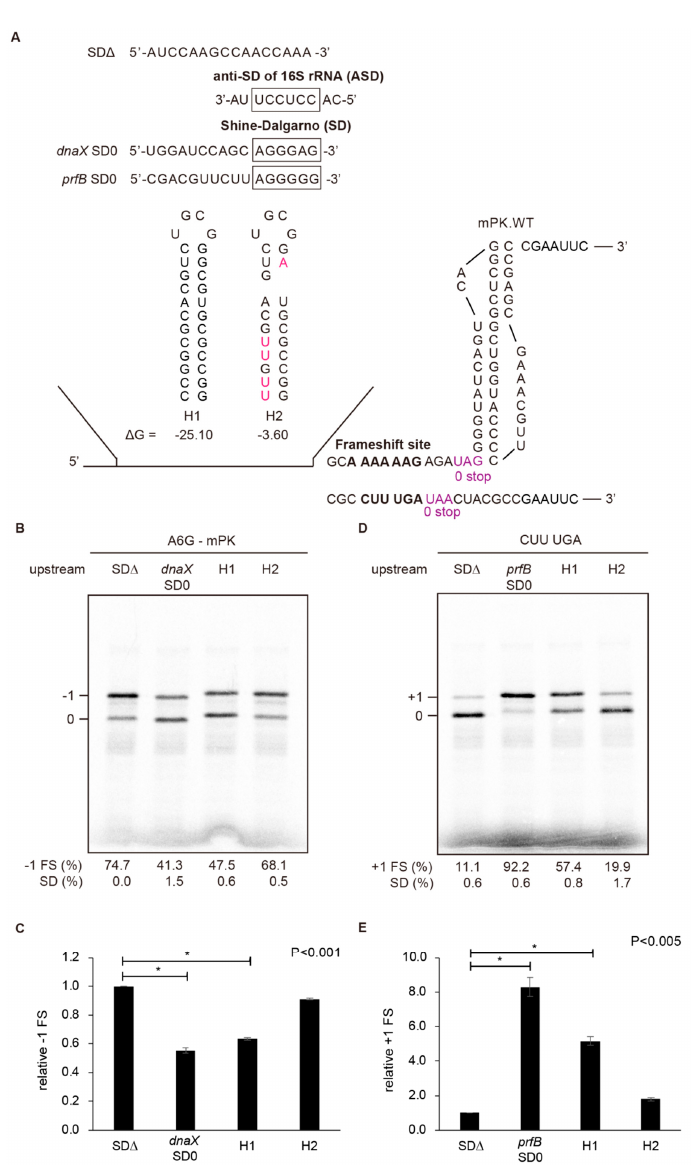
Figure 2. Stimulation of +1 frameshifting as well as attenuation of − 1 frameshifting by internal SD-mediated duplex mimicries in an in vitro 70S translation system. ( A ) Sequences, predicted secondary structures and free energy of distinct upstream hairpins evaluated. Mfold [25] was used for mRNA secondary structure and free energy prediction. Effects of upstream duplex variants on − 1 and +1 frameshifting were evaluated using respective A6G and CUUUGA frameshifting sites inserted in pET GST-Rluc-1 reporters. Due to the exclusion of RF2 in the reaction, a UAA or UAG stop codon was used as the 0 frame stop codon (in purple color), while UAA was used as the out of frame premature stop codons in the N-terminal region of Rluc. Mutations to disrupt the stem of H1 were typed in rose-red color. ( B ) Radioactivity-based − 1 PRF assay by SDS-PAGE analysis of 35 S methionine-labeled in vitro translation products, with calculated − 1 PRF efficiencies shown, for different upstream duplex constructs in ( A ). The values displayed are means ± SD of three independent experiments. ( C ) Relative − 1 PRF activity of frameshifting activities in ( B ) compared to SD ∆ with asterisks indicating p value < 0.001 using Student’s t -test. ( D ) Radioactivity-based +1 PRF assay by SDS-PAGE analysis of 35 S methionine-labeled in vitro translation products, with calculated +1 frameshifting efficiencies shown, for different upstream duplex constructs in ( A ). The values displayed are means ± SD of three independent experiments. ( E ) Relative +1 PRF activity of ( D ) compared to SD ∆ with asterisks indicating p value < 0.005 using Student’s t